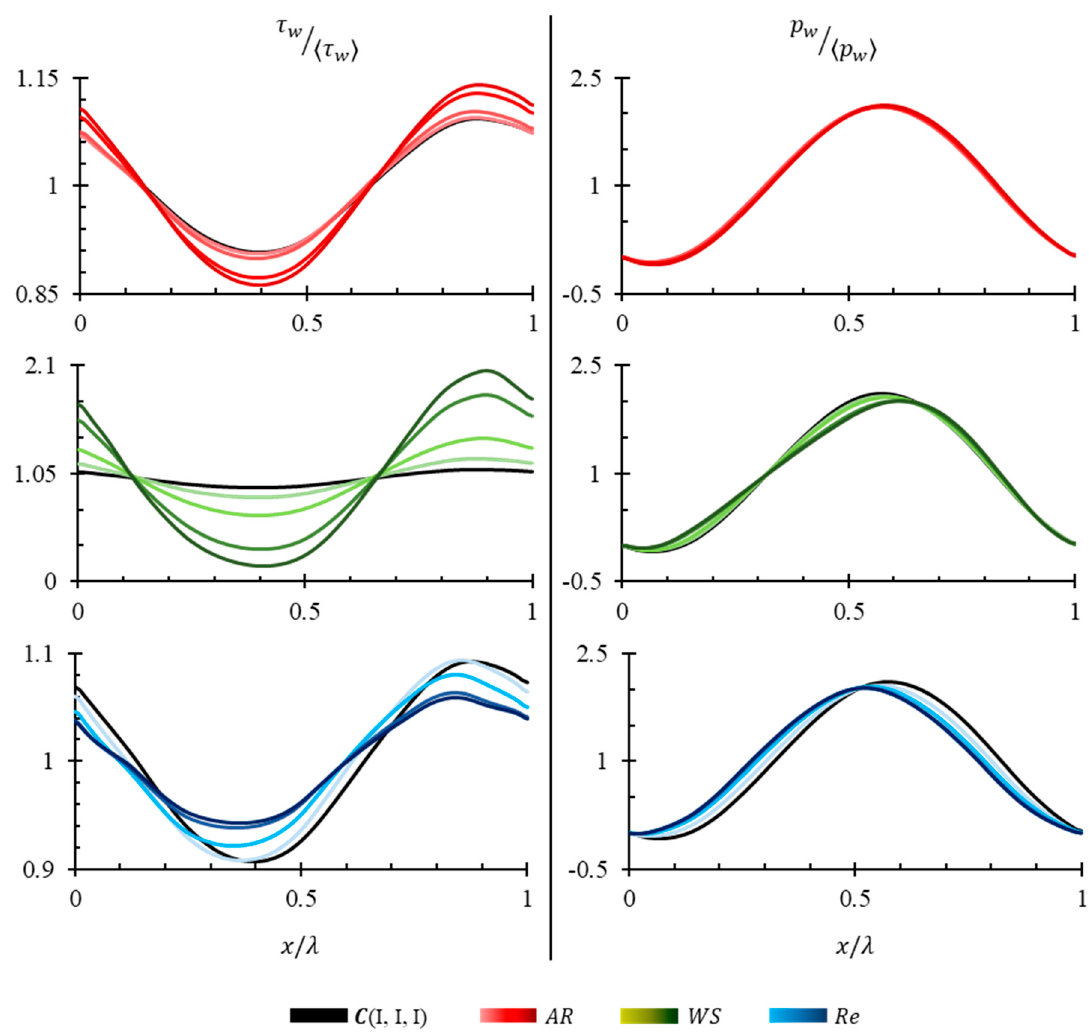
Figure 13. Influence of parameters on the normalized shear stress experienced by the bottom plate.